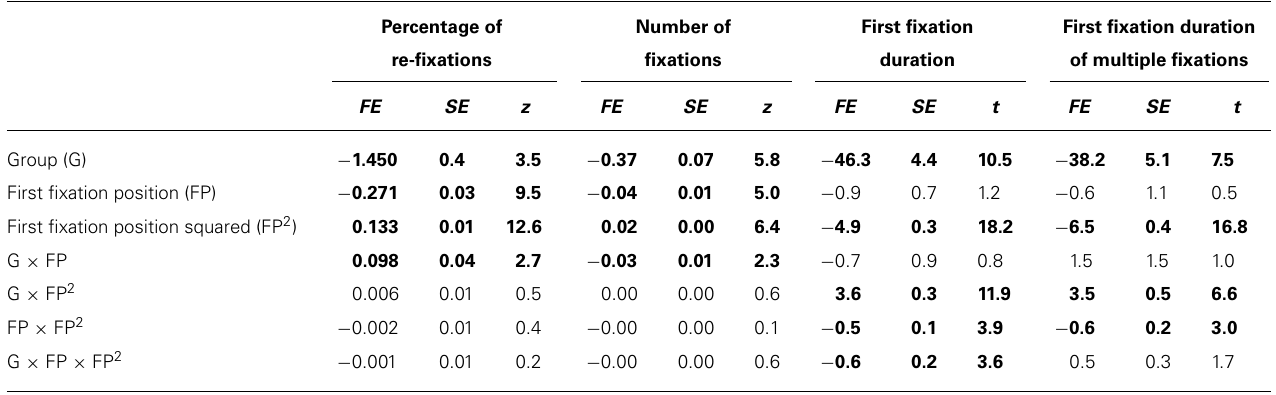
Table 2 | Results from the LMM analysis for the percentage of re-fixations, number of fixations, first fixation durations and first fixation durations of multiple fixation